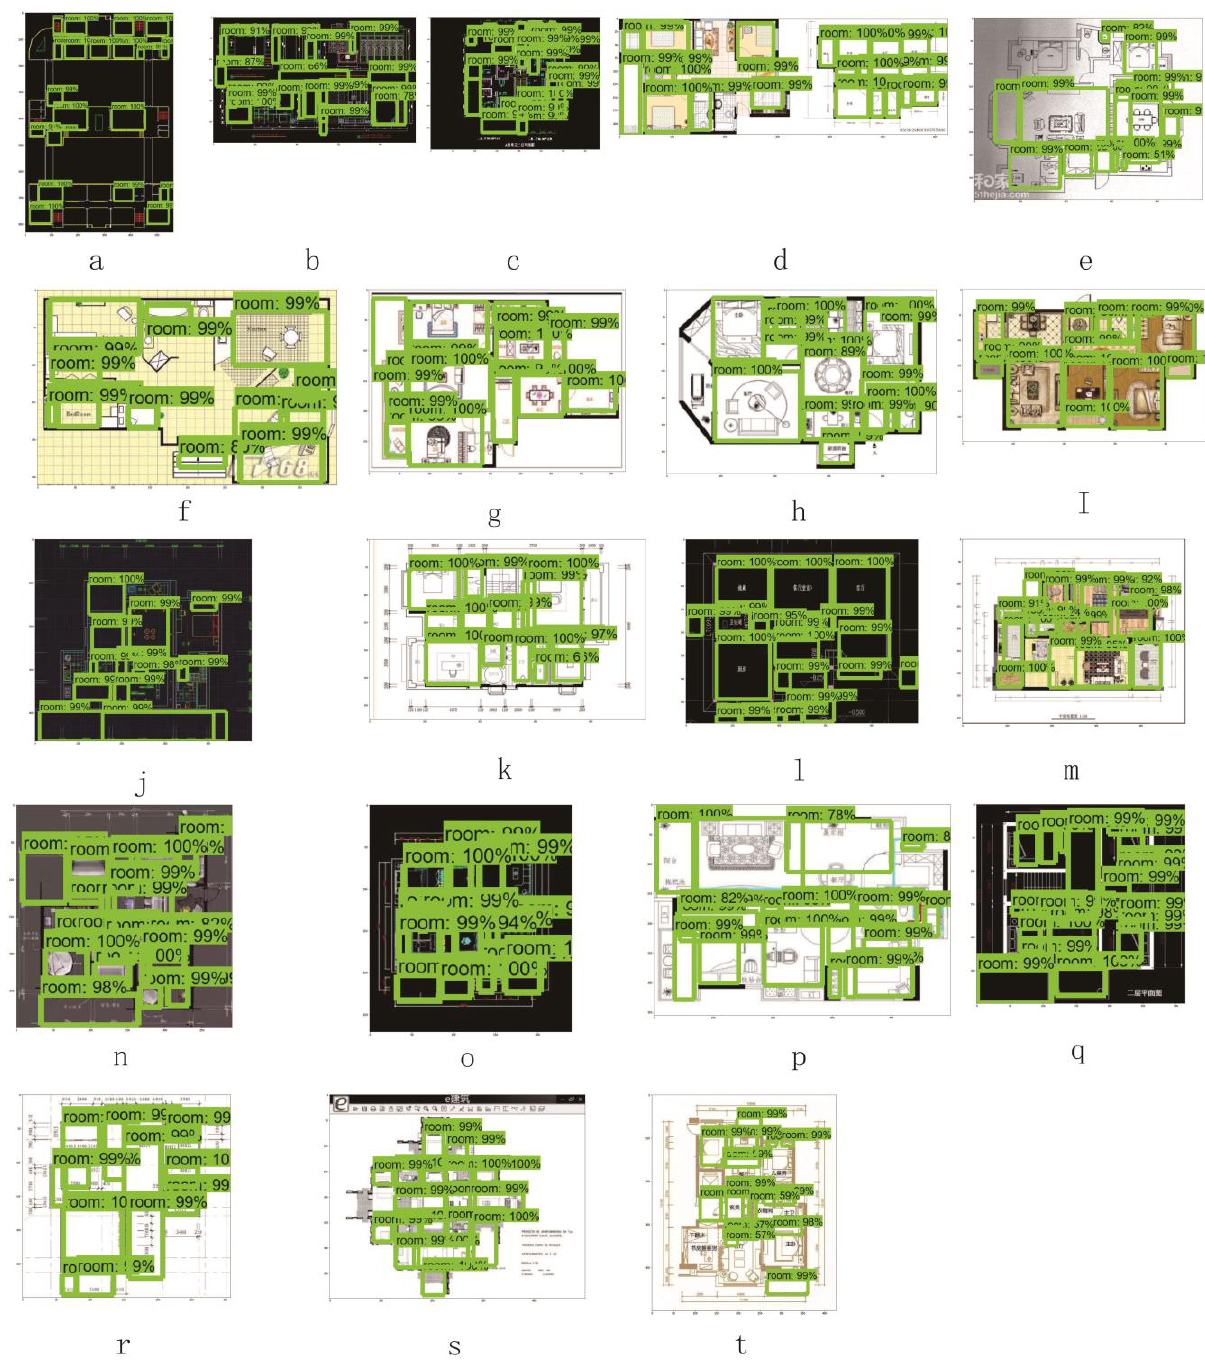
Figure 9. Illustration of navigation extraction result for CAD